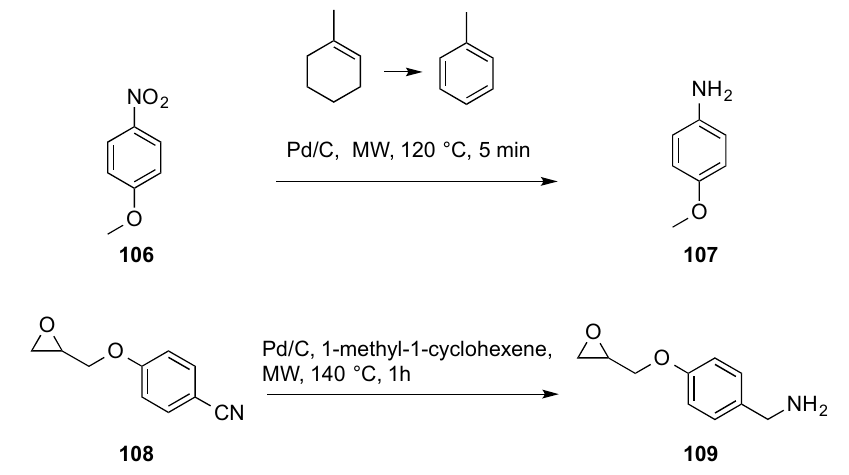
Scheme 31. Pd/C catalyzed hydrogen transfer with